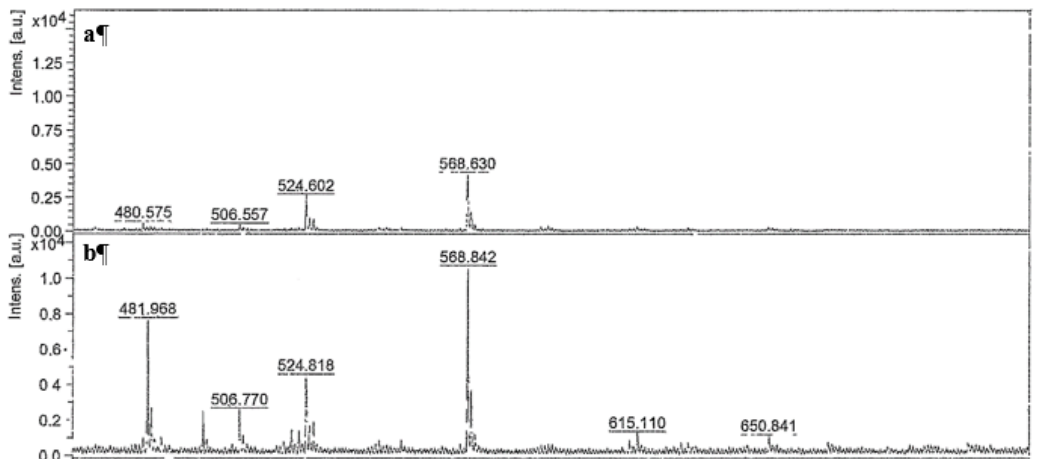
Figure 10 . Detail of the mass spectrum of commercial insulin ( a ) and the hydrolysate of empty microcapsules ( b ) in the 0–700 m/z region.